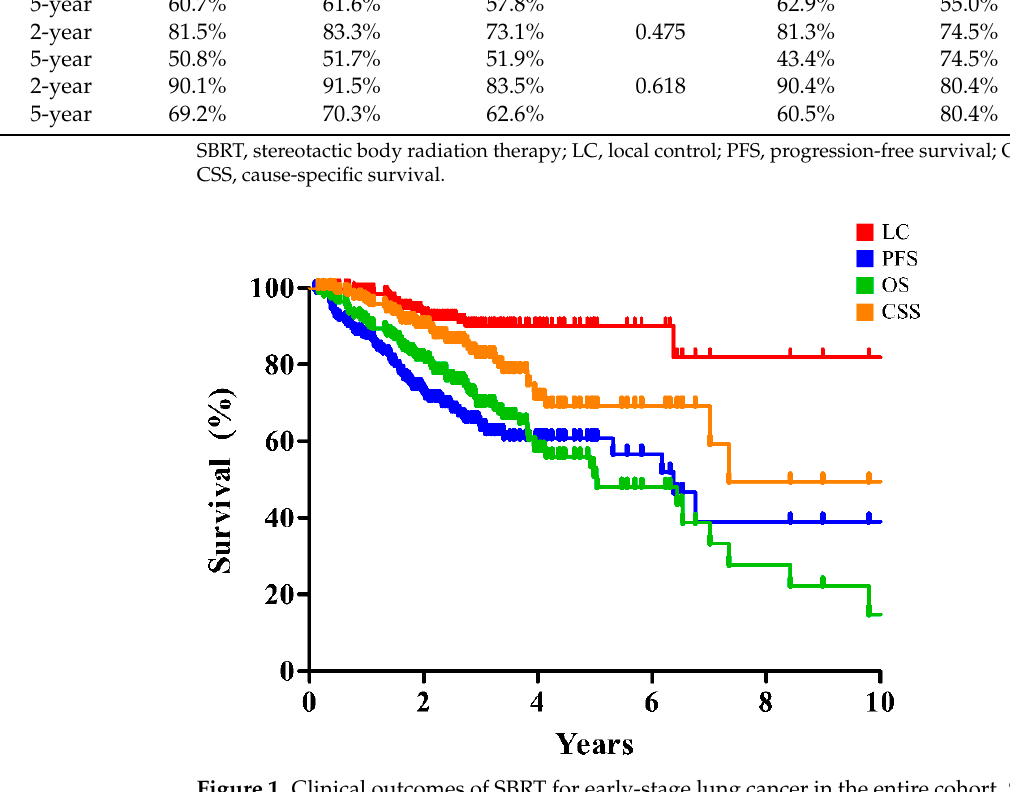
Figure 1. Clinical outcomes of SBRT for early-stage lung cancer in the entire cohort. SBRT, stereotactic body radiation therapy; LC, local control; PFS, progression-free survival; OS, overall survival; CSS, cause ‐ specific survival.